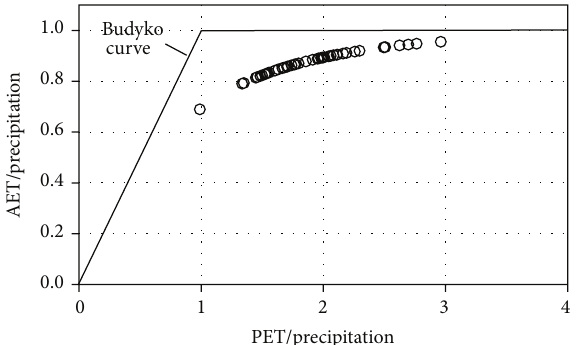
Figure 10: Relation between annual AET/precipitation and annual